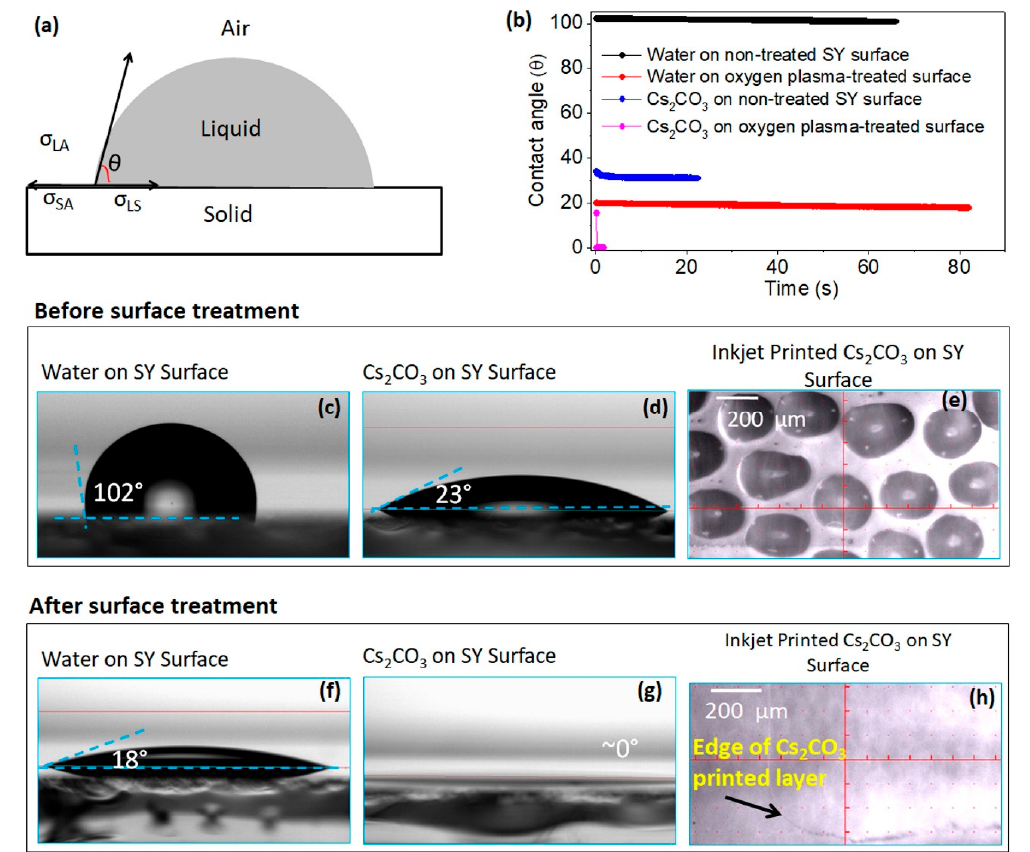
Figure 2. ( a ) A schematic illustration of a drop on solid surface. σ SL σ SA , and σ LA are three interFigure 2. CO 3 solution on both non-treated and oxygen plasma-treated surface. ( b ) Contact angle before surface treatment of ( c ) Water ( d ) Cs 2 CO 3 ink on the SY (Super Yellow, poly (para-phenylene vinylene) surface. ( e ) Inkjet printed Cs 2 CO 3 layer on SY layer before surface treatment. Contact angle after surface treatment of ( f ) water ( g ) Cs 2 CO 3 ink on SY surface. ( h ) Inkjet printed Cs 2 CO 3 layer on SY after surface treatment.